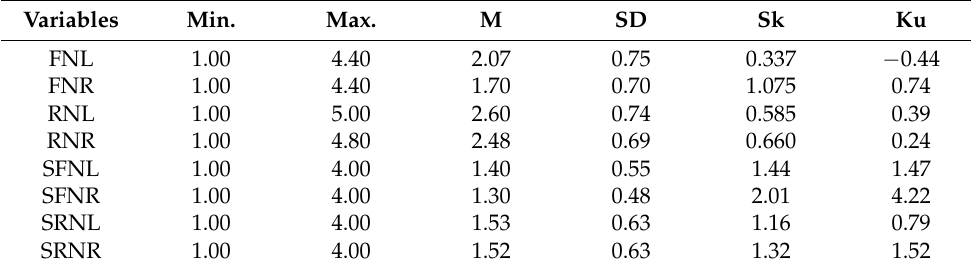
Table 3. Descriptive measures and univariate